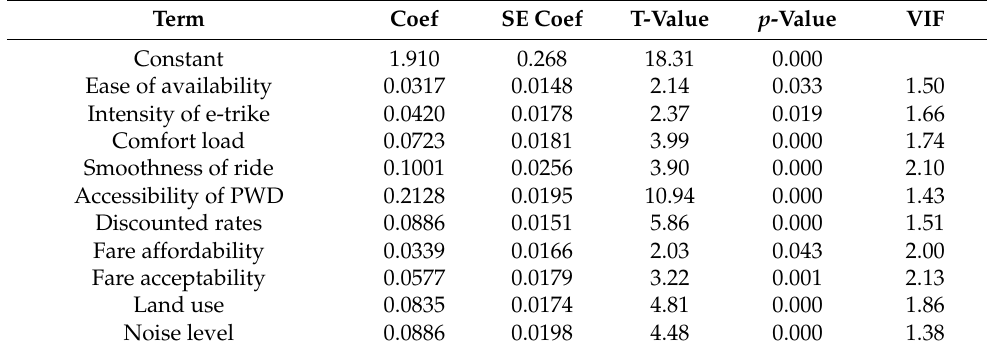
Table 9. Regression analysis of sustainability indicators associated with service